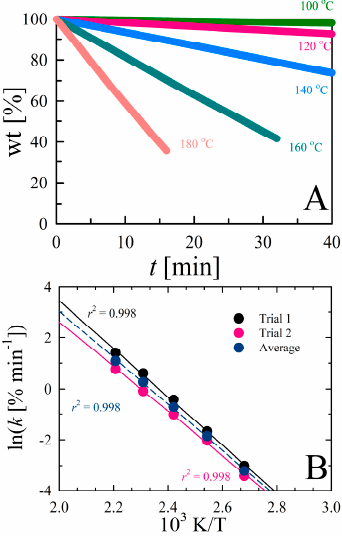
Figure 1. ( A ) Normalized mass loss curves for glycerol determined at various temperatures under nitrogen purge. ( B ) Comparison of temperature-dependent glycerol evaporation rates measured using isothermal gravimetry for two different trials. The average response for this particular apparatus (TGA-1) is denoted by the dashed profile.